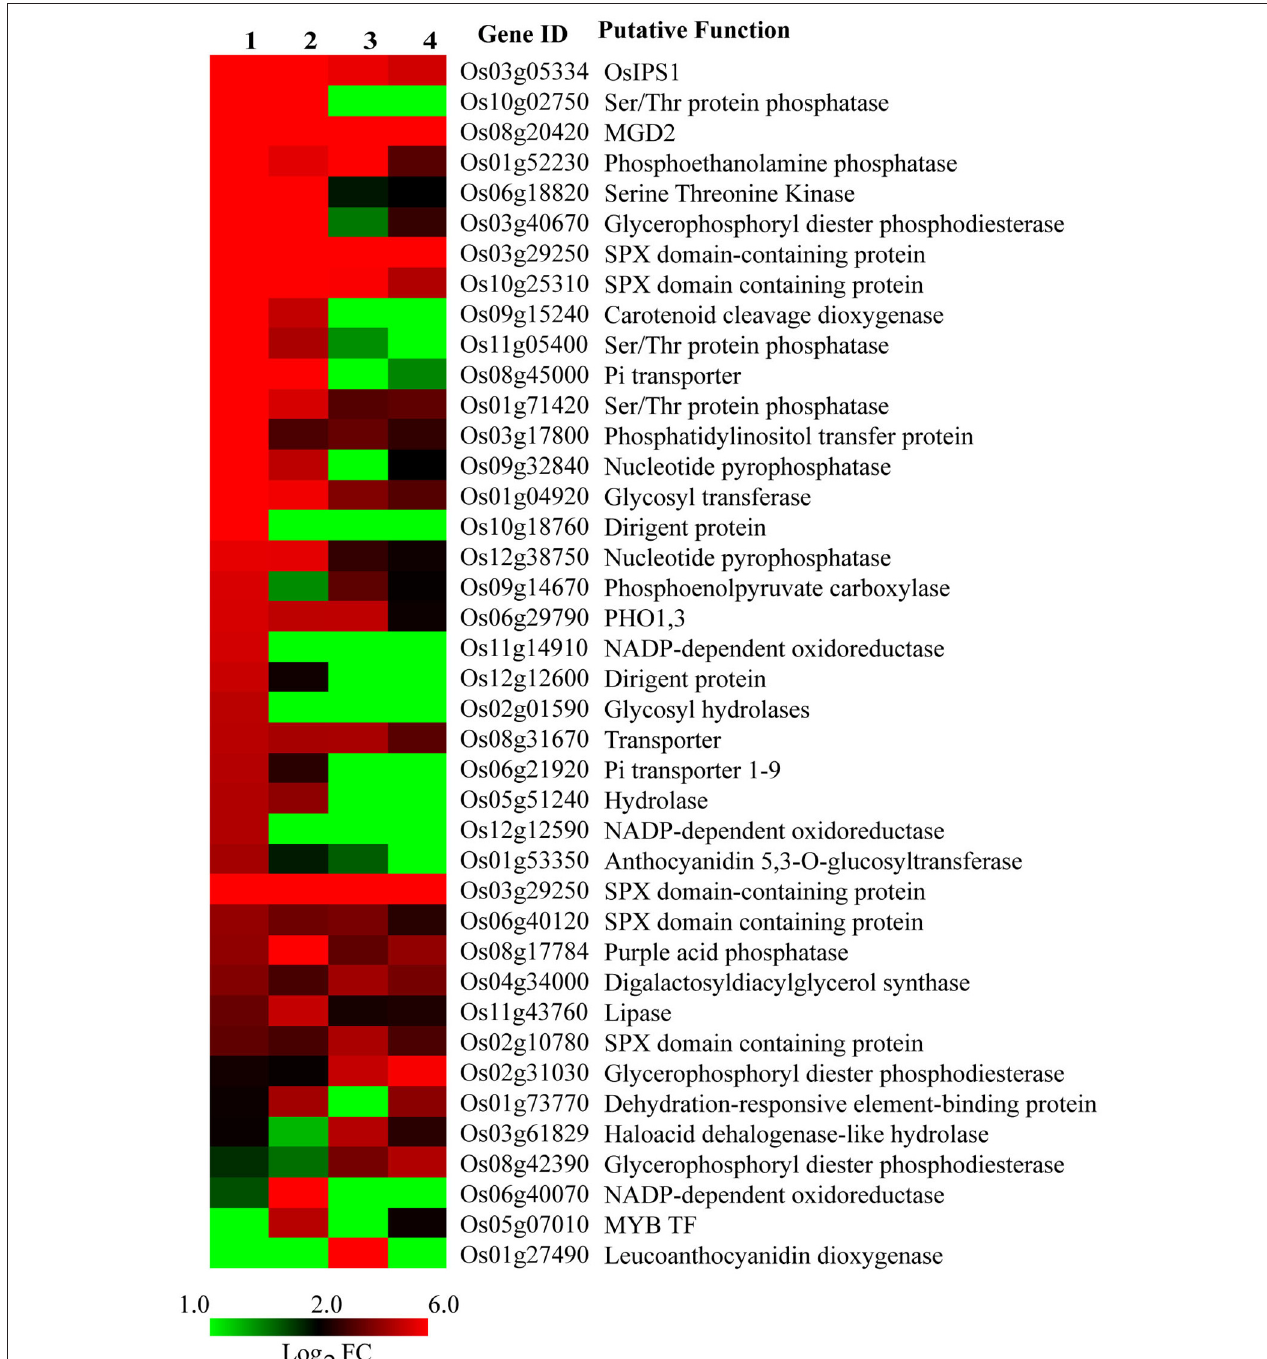
FIGURE 3 | Expression profile of known PSR genes under Pi deficiency. Gene list was compiled from published reports. 1, Dular root; 2, PB1 root; 3, Dular shoot; 4, PB1 shoot.